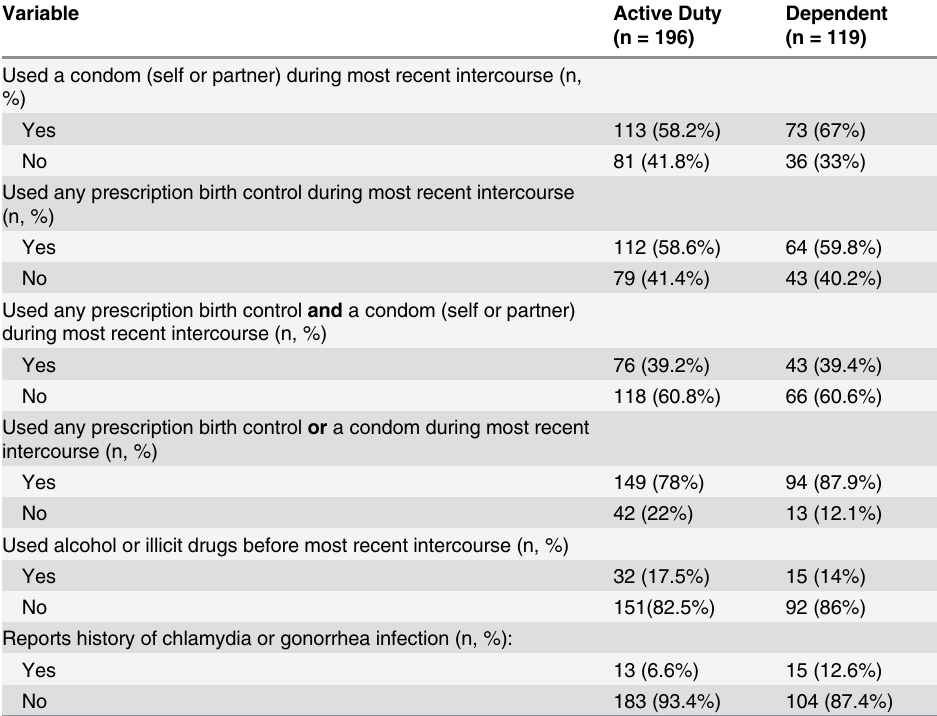
Table 2. Risk behaviors among patients who indicated history of sexual intercourse in military ado- lescent clinics (n = 315). Variable Active Duty